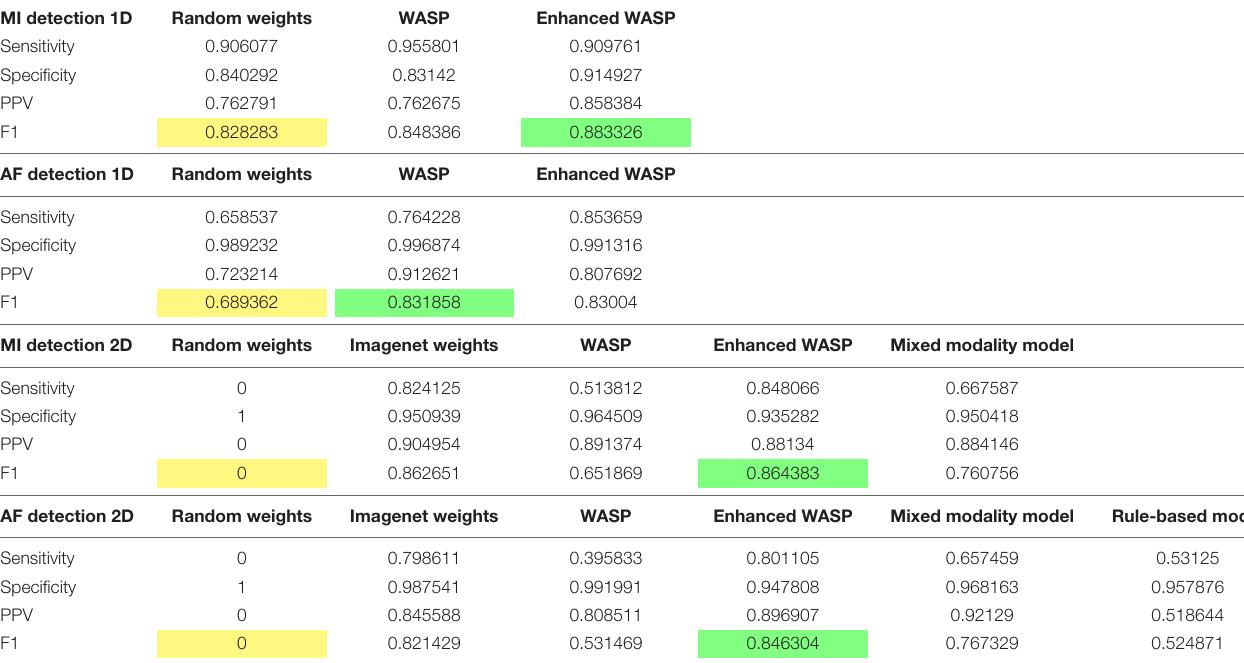
TABLE 1 | Test set results for the two diagnostic classification tasks.